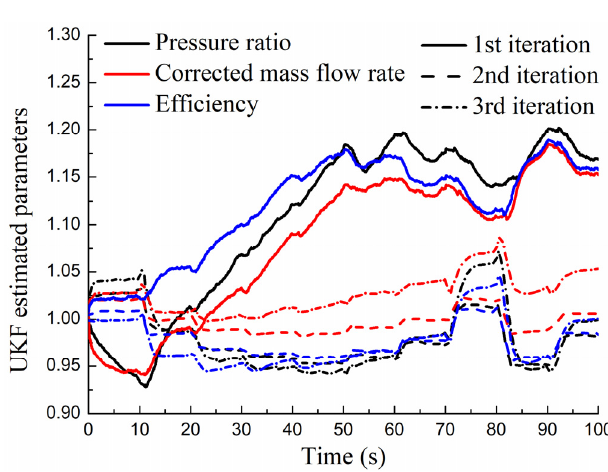
Figure 19. Estimation procedure of UKF.